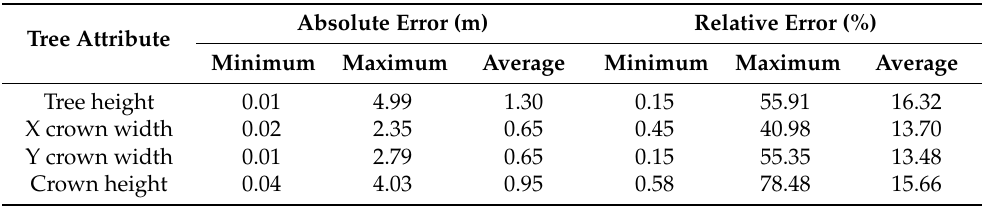
Table 4. Tree attribute extraction results.